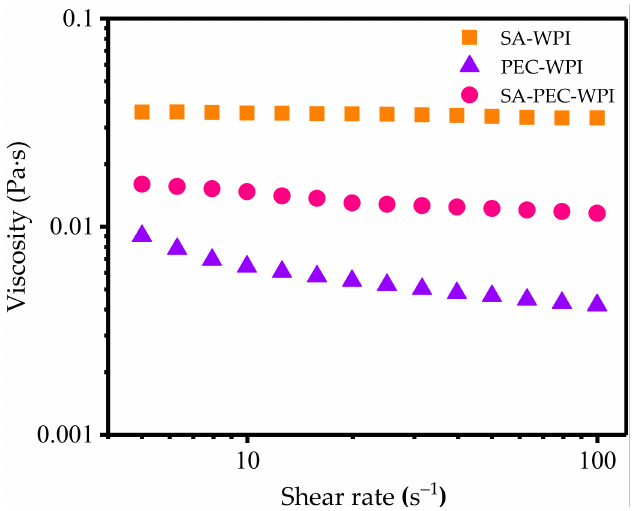
Figure 5. The viscosity of SA-WPI, PEC-WPI, SA-PEC-WPI emulsions. SA: sodium alginate; PEC: pectin; WPI: whey protein isolate.